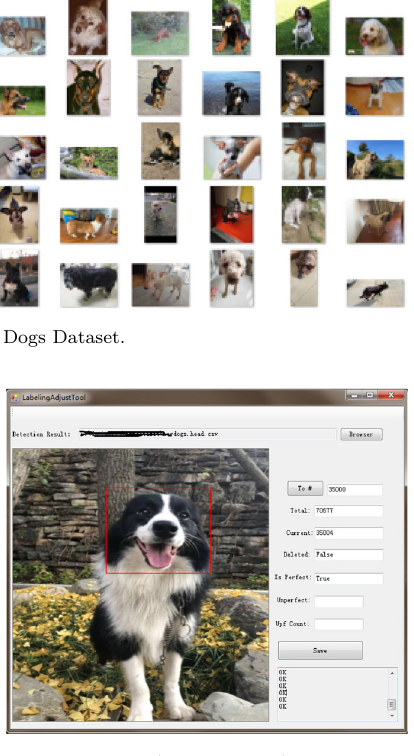
Fig. 5 Bounding boxes for whole dogs (blue) and their heads (red). Fig. 6 Adjustment